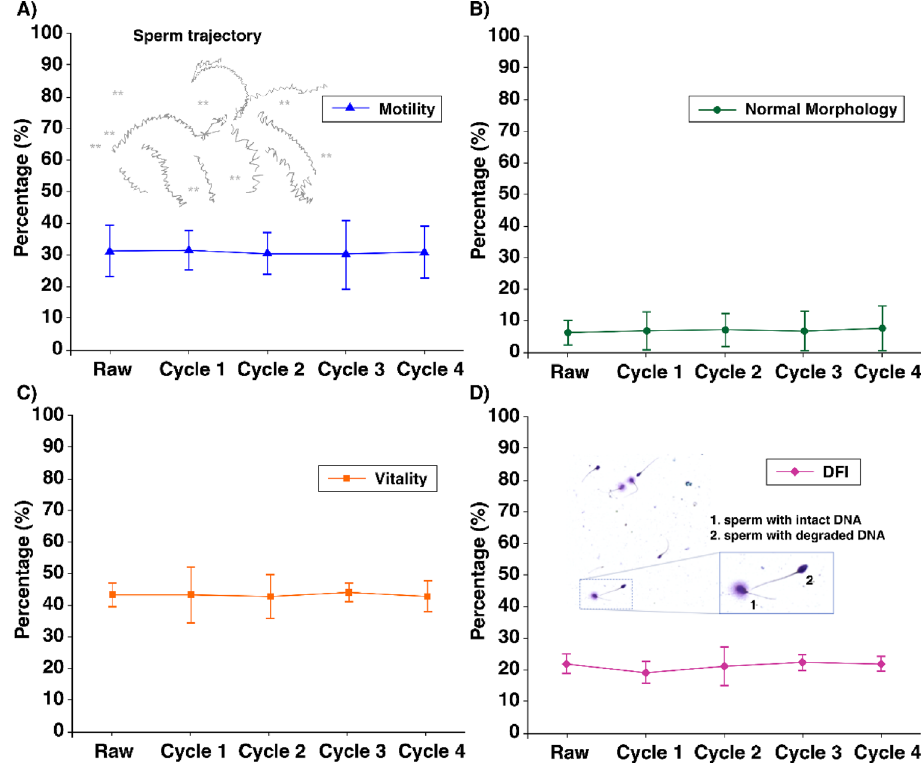
Figure 4. The influence of multiple separation cycles on ( A ) motility, ( B ) morphology, ( C ) vitality and ( D ) DFI of the retrived sperm as compared with the initial raw sample. ( D ) (i) Example images of SCD assayed sperm with sperm 1. Showing intact DNA and sperm 2. Showing degraded DNA. N = 3 for each